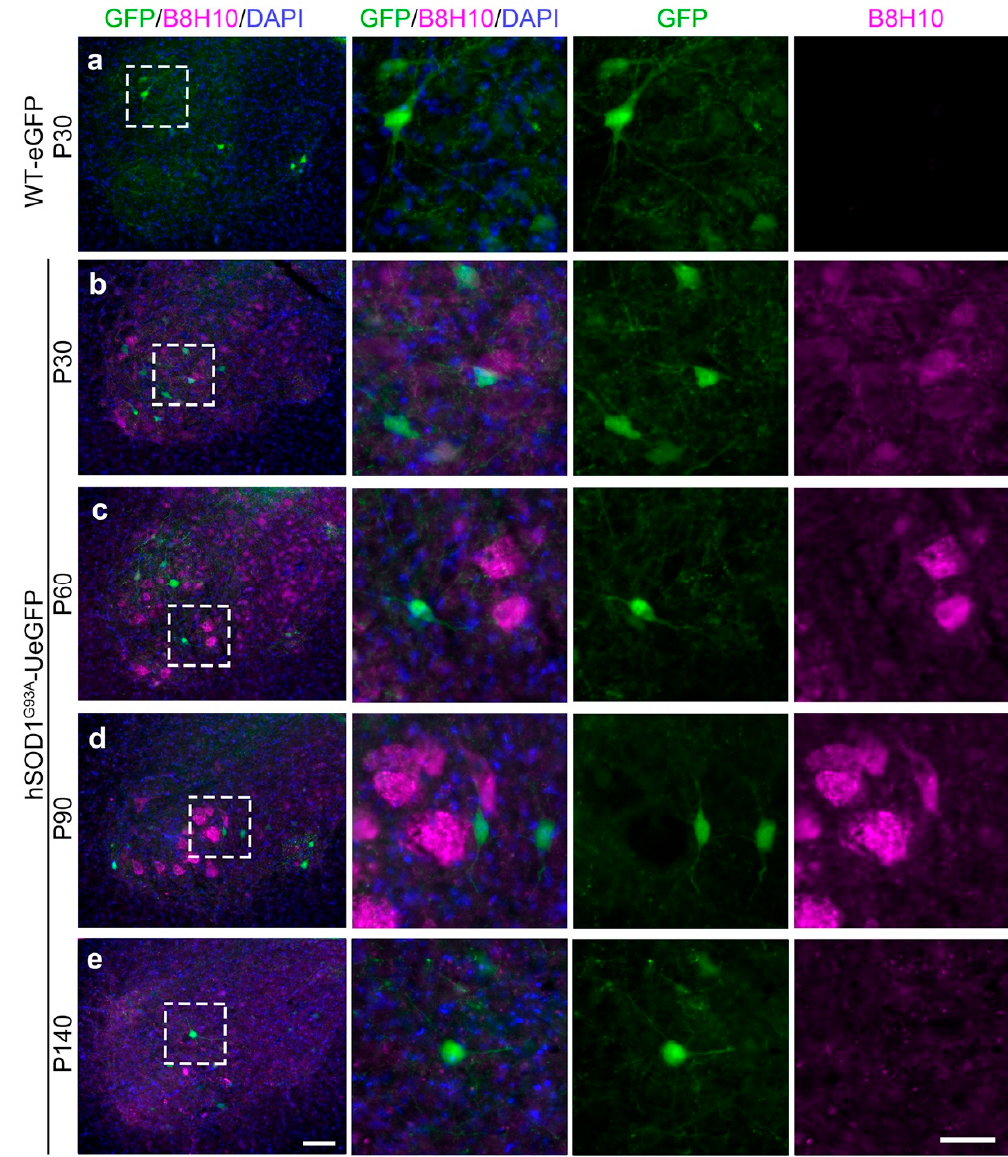
Figure 4. Misfolded SOD1 protein in the ventral horn of the lumbar spinal cord. ( a ) There is no misfolded SOD1 protein in the spinal cord of WT-UeGFP control mice; ( b – e ) misfolded SOD1 protein are detected in the lumbar spinal cord of hSOD1 G93A -UeGFP mice by the B8H10 antibody and degeneration resistant eGFP + SMN do not have misfolded SOD1 at P30 ( b ), P60 ( c ), P90 ( d ), and P140 ( e ). Boxed areas enlarged in the right panels. Scale bar, 100 µ m (left, low mag) and 50 µ m (right, high mag).